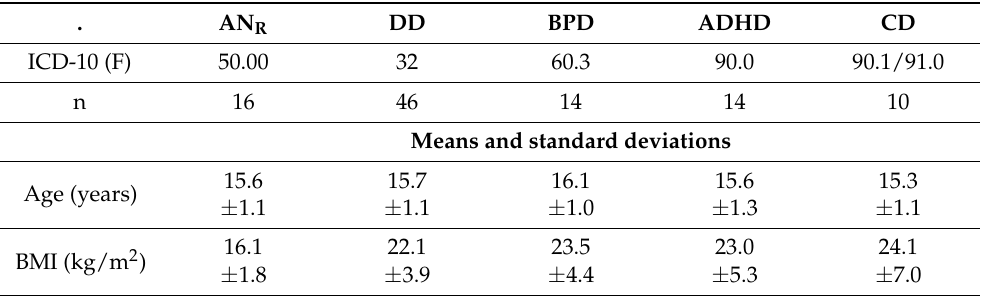
Table 1. Characterization of patient groups: Anorexia nervosa restrictive type (AN R ), depressive disorder (DD), borderline personality disorder (BPD), attention deficit hyperactivity disorder (ADHD), conduct disorder (CD), body mass index (BMI). . AN R DD BPD ADHD CD ICD-10 (F) 50.00 32 60.3 90.0 90.1/91.0 n 16 Means and standard deviations Age (years) BMI (kg/m 2